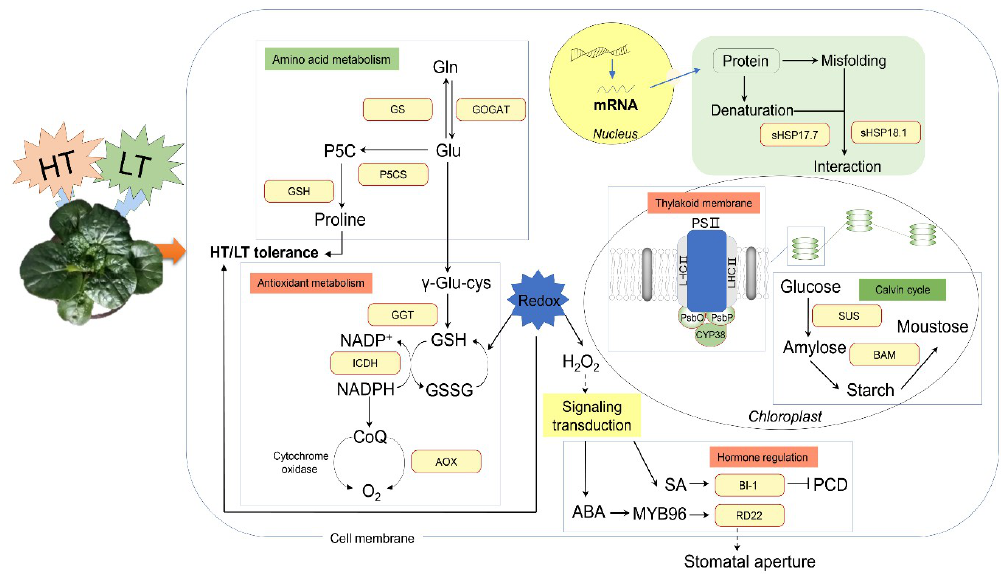
Figure 10. Schematic diagram of WS-1 proteins that were upregulated in response to both LT and HT. Red border represents upregulated proteins, arrows indicate positive regulation, and T-bars indicate negative regulation.